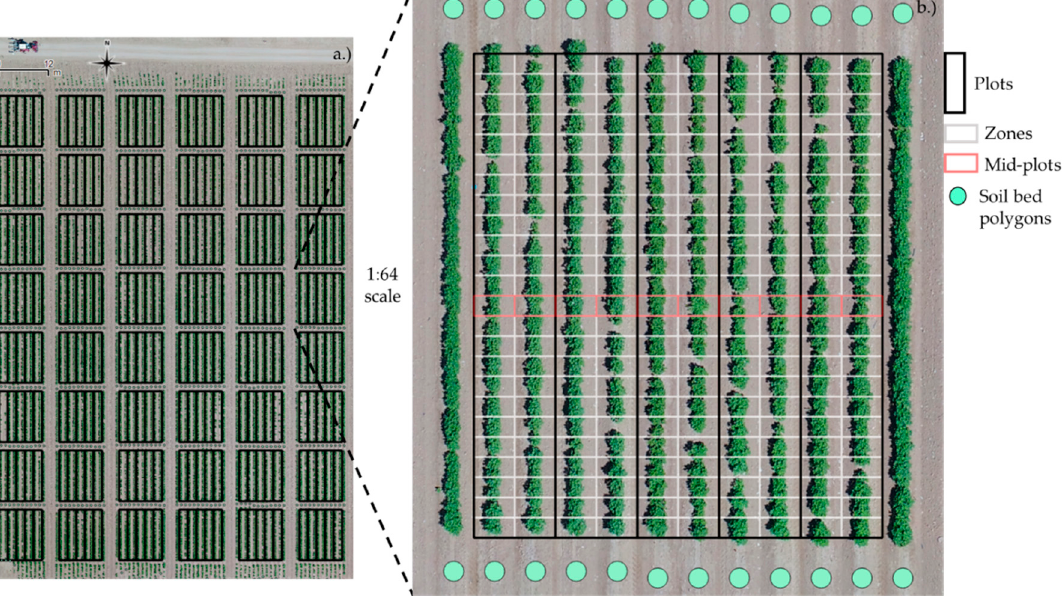
Figure 2. Field experimental layout ( a ) for a cotton study comparing regional breeders testing network germplasm with two irrigation rates in 2016 and 2017 growing seasons at Maricopa, Arizona, USA. The two-row, 12.1 m plots are outlined in black, the 48-plot zones are outlined in grey, the mid-plot for manual measurements are outlined in red, and the 0.5 m diameter soil bed polygons are colored green ( b ) shown with an RGB composite image of the field on 10 July 2017.